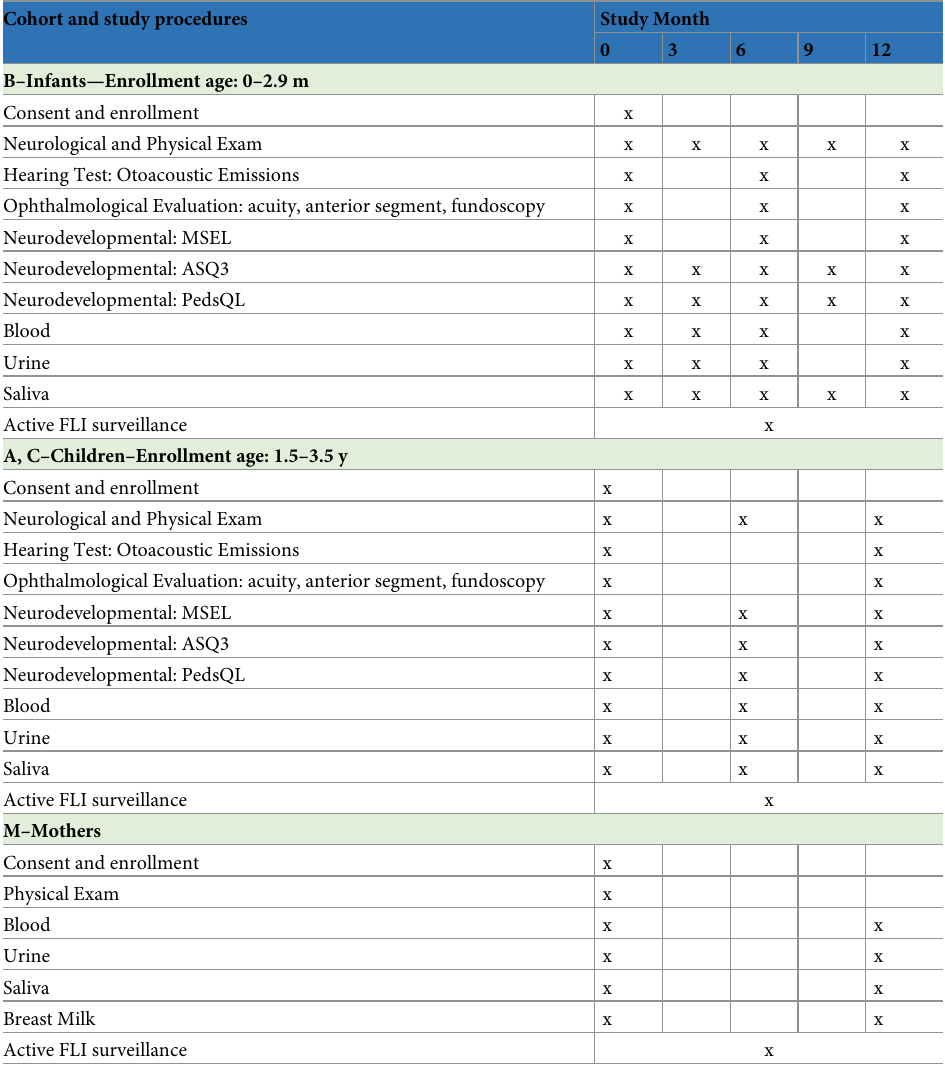
Table 1. Study schedule of procedures for each study